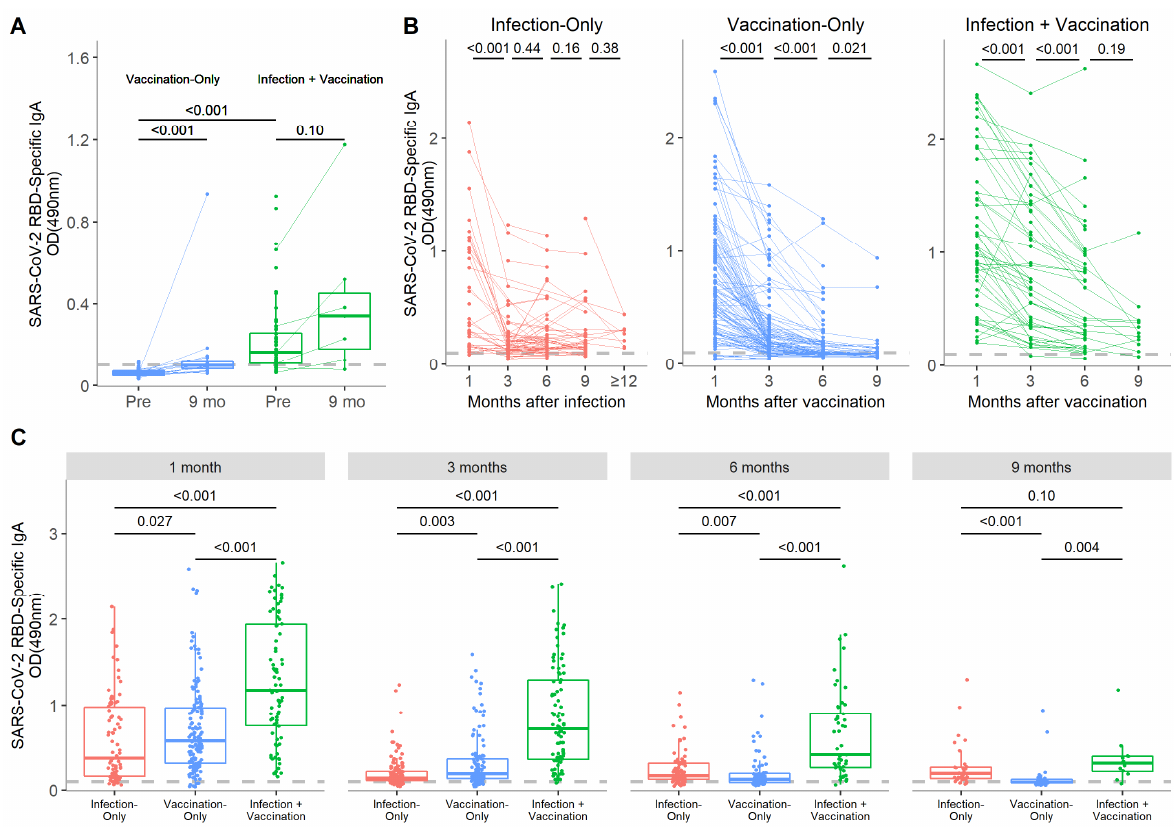
Figure 3. Serum levels of SARS-CoV-2-specific IgA over time after SARS-CoV-2 infection and COVID-19 mRNA vaccination, with or without prior immunity. ( A ) Levels of RBD-specific IgA pre-vaccination are compared with the paired 9 month samples in the vaccination-only and infection + vaccination groups. The threshold for RBD-specific IgA positivity was set at 0.104 OD 490 based on levels in pre-pandemic samples. ( B ) Analyses of the change in anti-RBD IgA levels over time are presented for paired samples from the infection-only, vaccination-only, and infection + vaccination groups. ( C ) At each time point, the RBD-specific IgA response was compared among samples from the infection-only, vaccination-only, and infection + vaccination groups. Boxes represent the median and interquartile range and whiskers represent the minimum and maximum values. p -values were calculated by Wilcoxon signed-rank tests if between paired time points or the Kruskal − Wallis test followed by Dunn’s multiple comparisons test if between multiple groups.